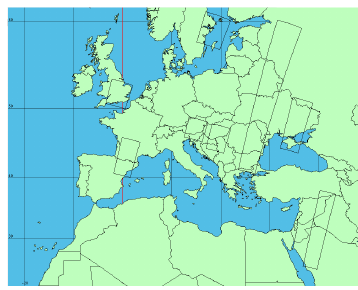
Figure 19. Footprints of refined products analyzed for multi- temporal registration assessments.